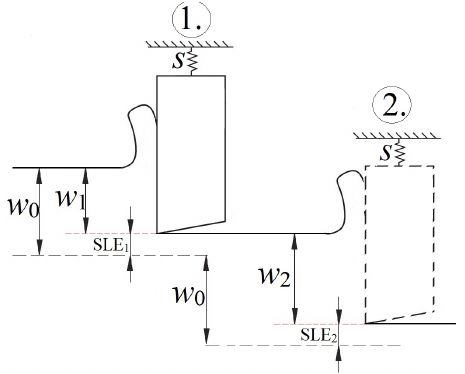
Figure 2. Evolution of the Surface Location Error ( SLE ) in consecutive immersions.